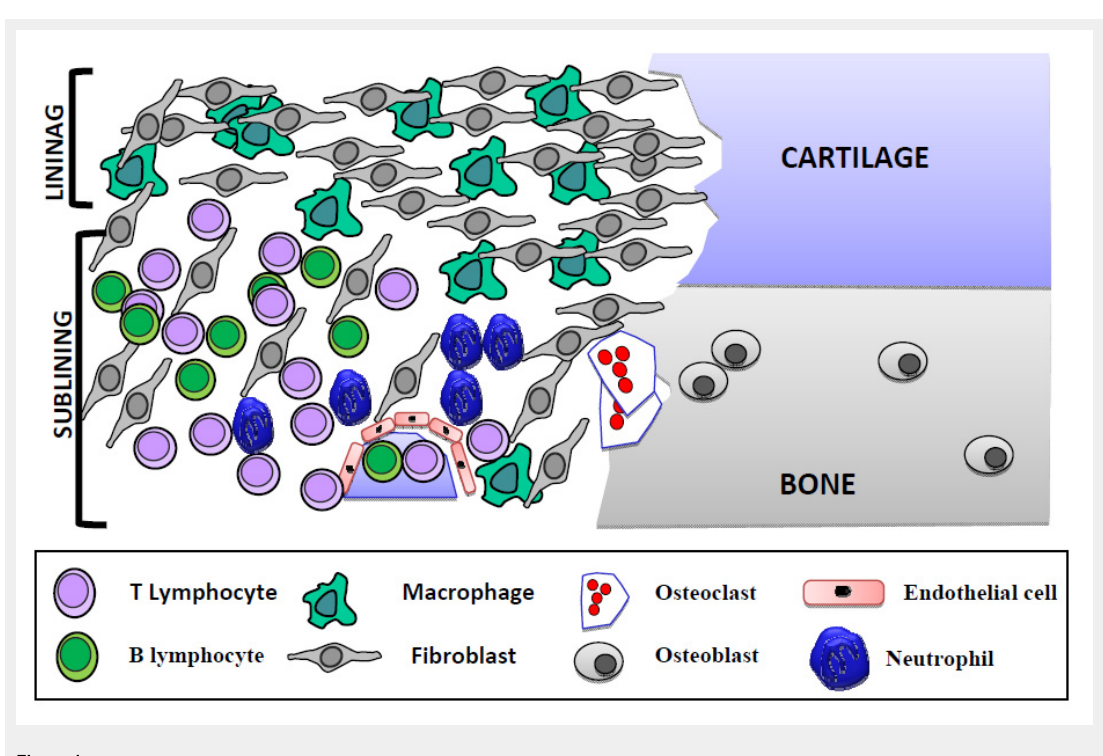
Figure 1 Representation of the different cell types in the rheumatoid synovium.